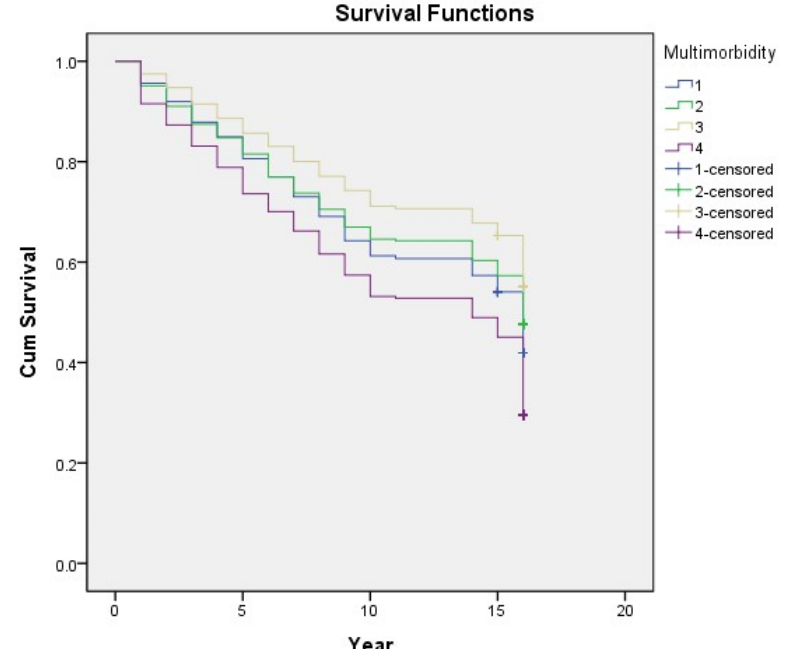
Figure 6. Association between each multimorbidity group in 1996 and long-term mortality in older adults. 1 (blue line): cardiometabolic group; 2 (green line): arthritis–cataract group; 3 (yellow line): relatively healthy group; 4 (purple line): multimorbidity group. Cum survival: cumulative survival.